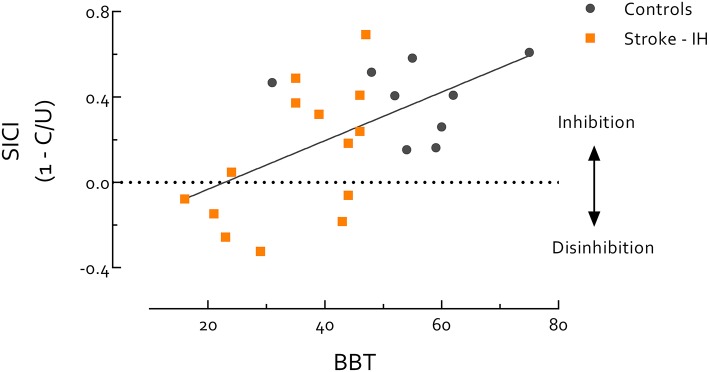
Short intracortical inhibition (SICI) measured during box and blocks task (B and B) is significantly correlated with Box and Blocks Test (BBT) score. Correlation includes all participants, stroke survivors and healthy controls, and all participants were evaluated on the same continuum. Most healthy controls showed better performance in BBT than stroke survivors, but there is also a region of overlap in BBT between healthy controls and stroke survivors. Individuals with better motor performance (i.e., healthy controls or high-functioning stroke survivors) tend to have more SICI during B and B, while individuals with poor motor performance (i.e., low-functioning stroke survivors) tend to have reduced SICI in IH during B and B (r = 0.57, P = 0.005). This result indicates that SICI-related inhibitory circuits may play an active role in coordinated motor activity. Of note, background EMG activity, S2 MEP size, and MEP/EMG during B and B were not significantly correlated with BBT score, therefore do not contribute to the correlation between SICI and BBT score. IH, ipsilesional hemisphere; MEP, motor-evoked potential. MEP/EMG refers to the ratio of S2 (unconditioned) MEP size to mean prestimulus EMG activity.